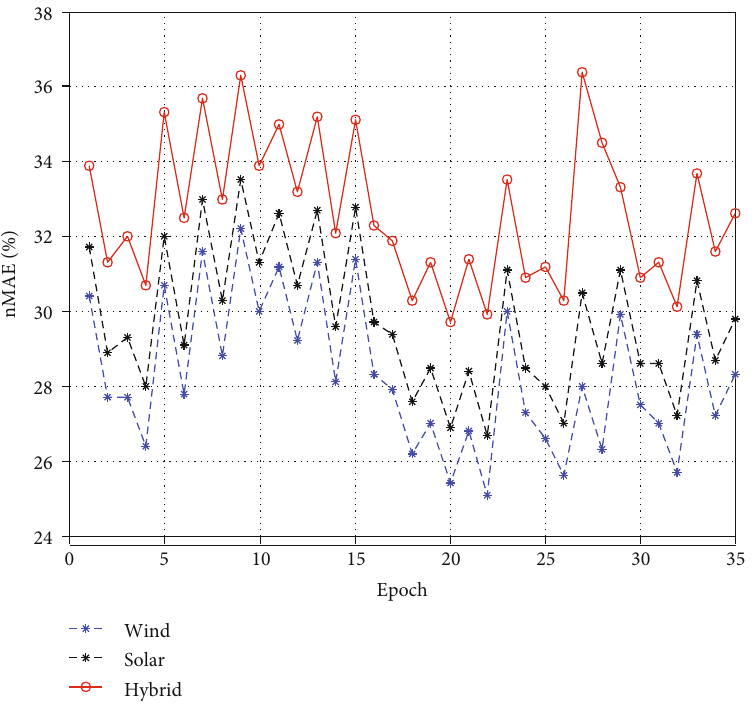
Figure 5: nMAE of all